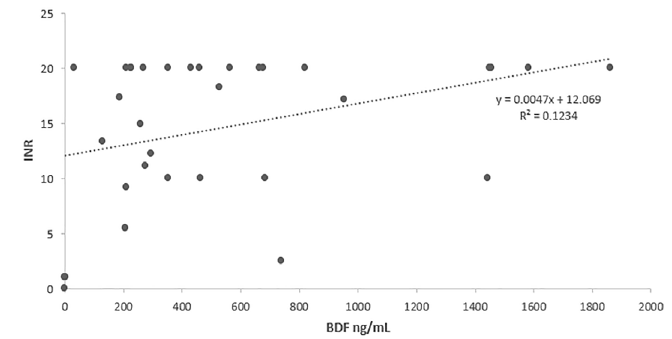
Figure 4. Serum brodifacoum levels plotted on X axis, INR plotted on Y axis. There is a linear correlation with respect to increasing serum brodifacoum levels and elevated INR. This likely is in part due to the volume of distribution into tissues. BDF, brodifacoum; INR, international normalized ratio; ng, nanogram; mL,